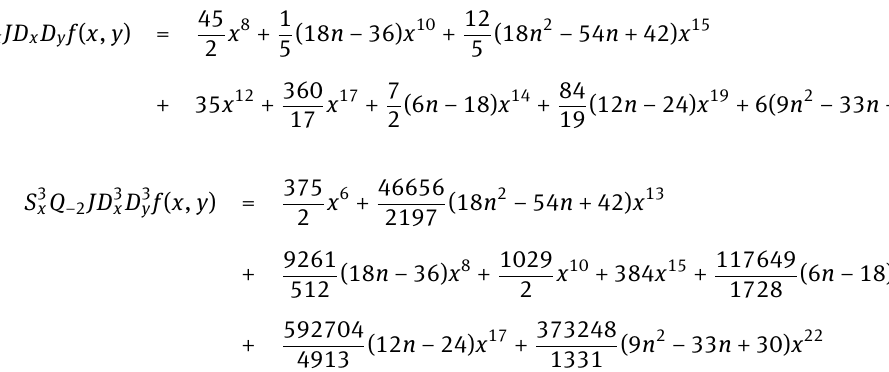
S x JD x D y f ( x , y )